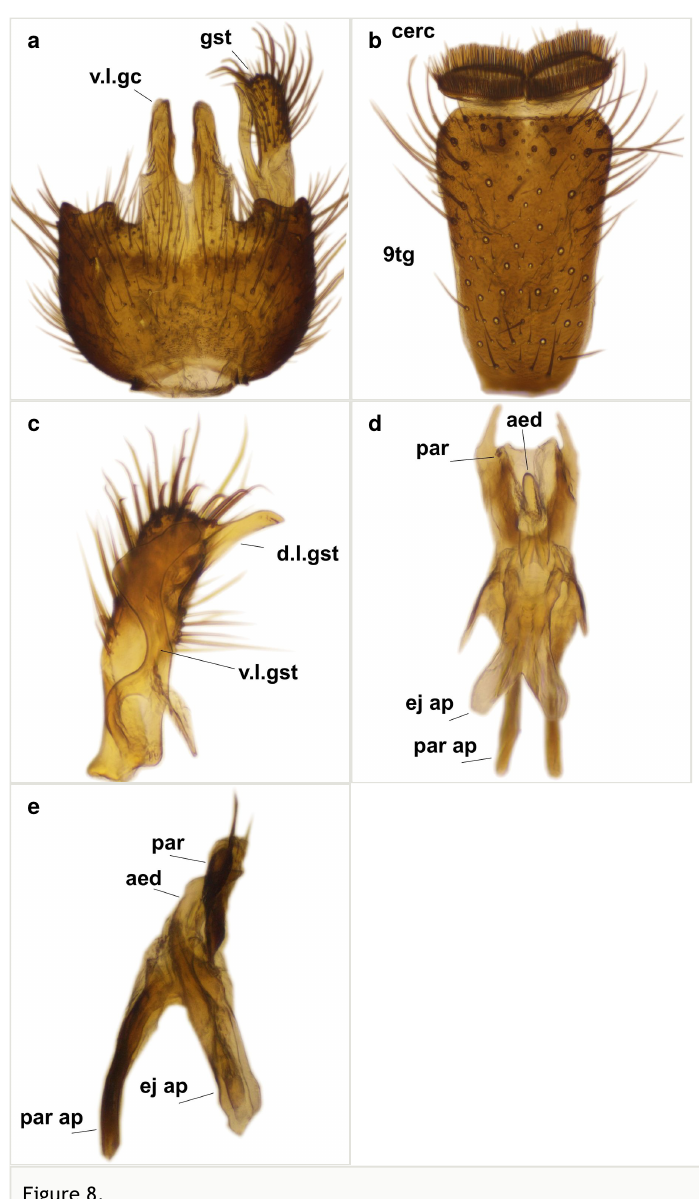
Figure 8. Boletina sasakawai Salmela & Kolcsár sp.n., holotype male, hypopygium. a : Hypopygium, ventral view. v.l.gc=ventral lobes of gonocoxites, gst=gonostylus. b : Cerci (cerc) and 9th tergite (9tg), dorsal view. c : Gonostlys, lateral view. d.l.gst=dorsal lobe of gonostylus, v.l.gst=ventral lobe of